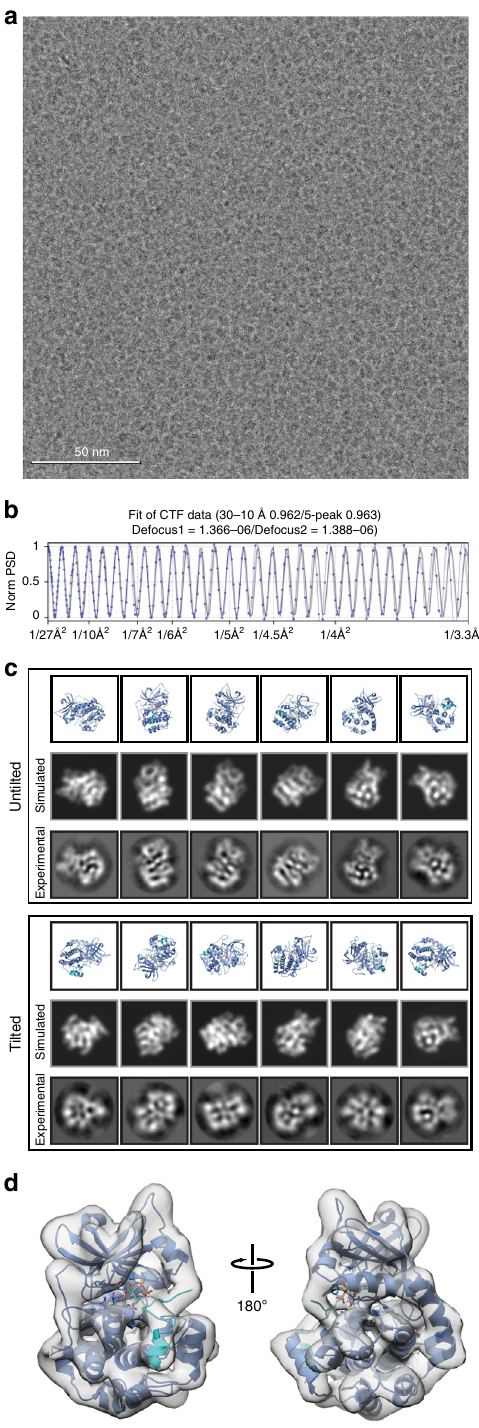
conformational states within a single sample, respectively, can be resolved using conventional SPA even for smaller complexes.